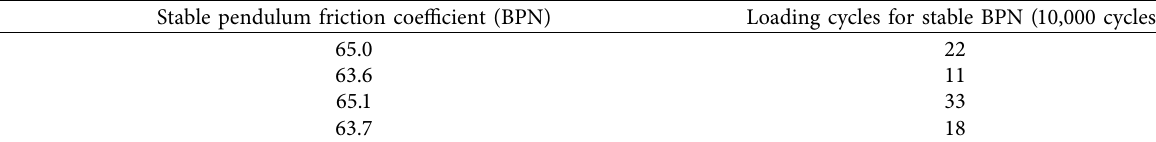
Table 10: BPN evaluation indicators and calculation results.